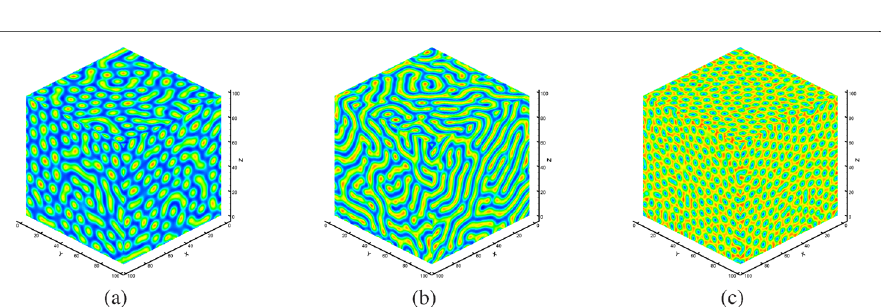
Figure 2 H 0 hexagon, stripe, and H π hexagon pattern of CIMA model at t = 10 4 for